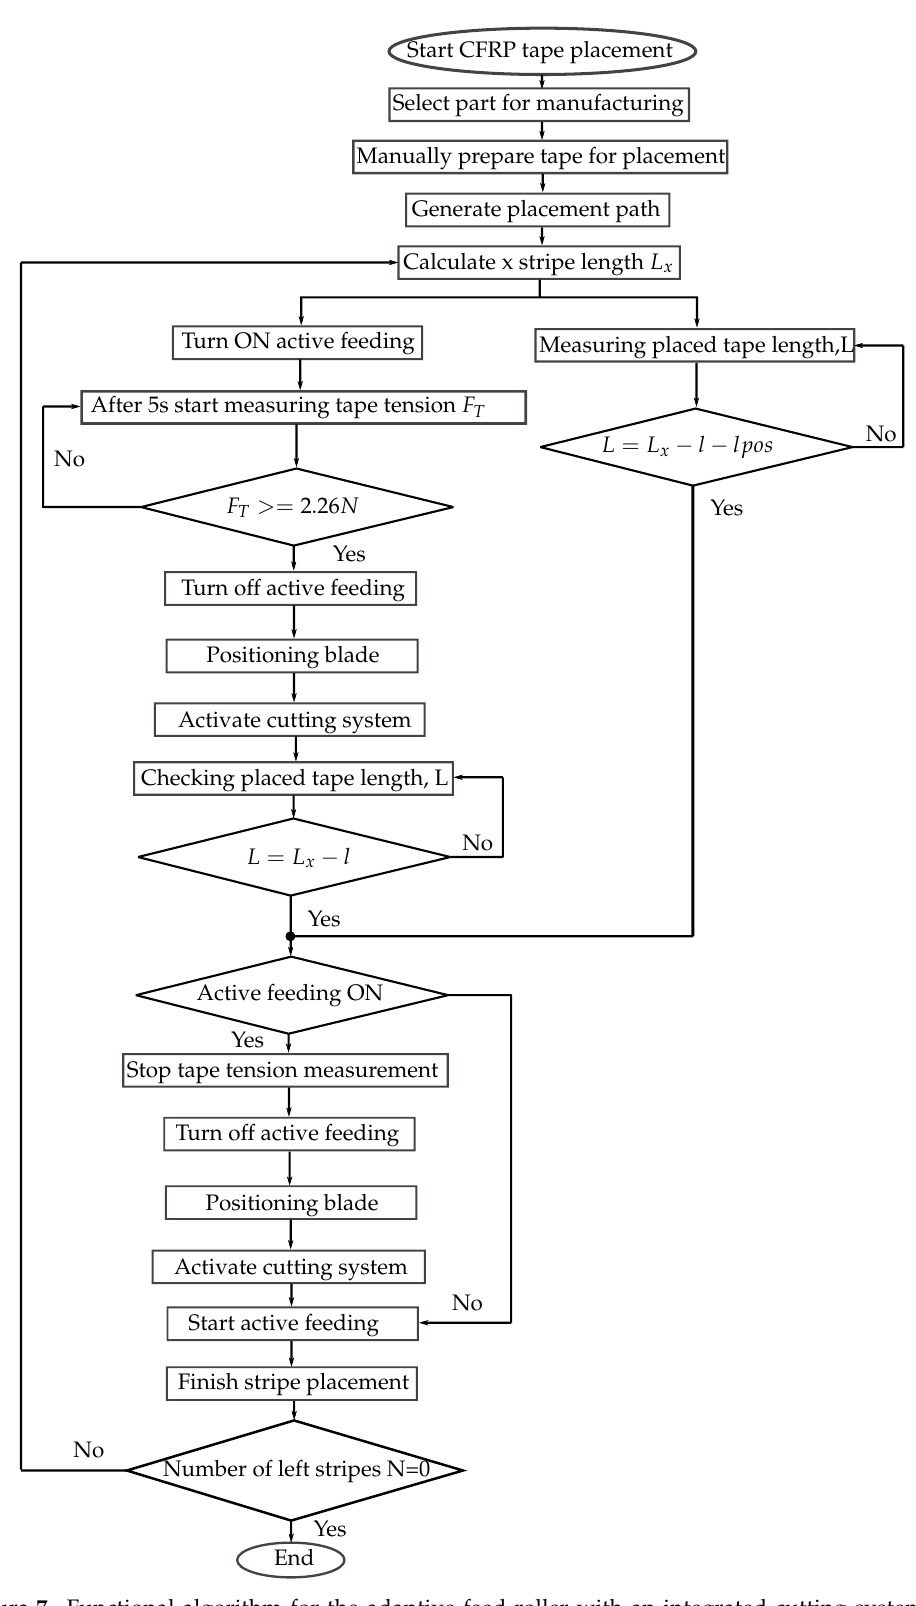
Figure 7. Functional algorithm for the adaptive feed roller with an integrated cutting system for automated fiber placement